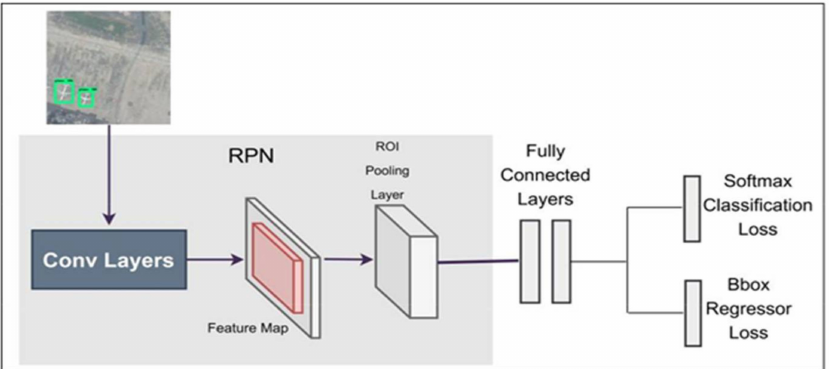
Figure 4. Overview of Faster RCNN network